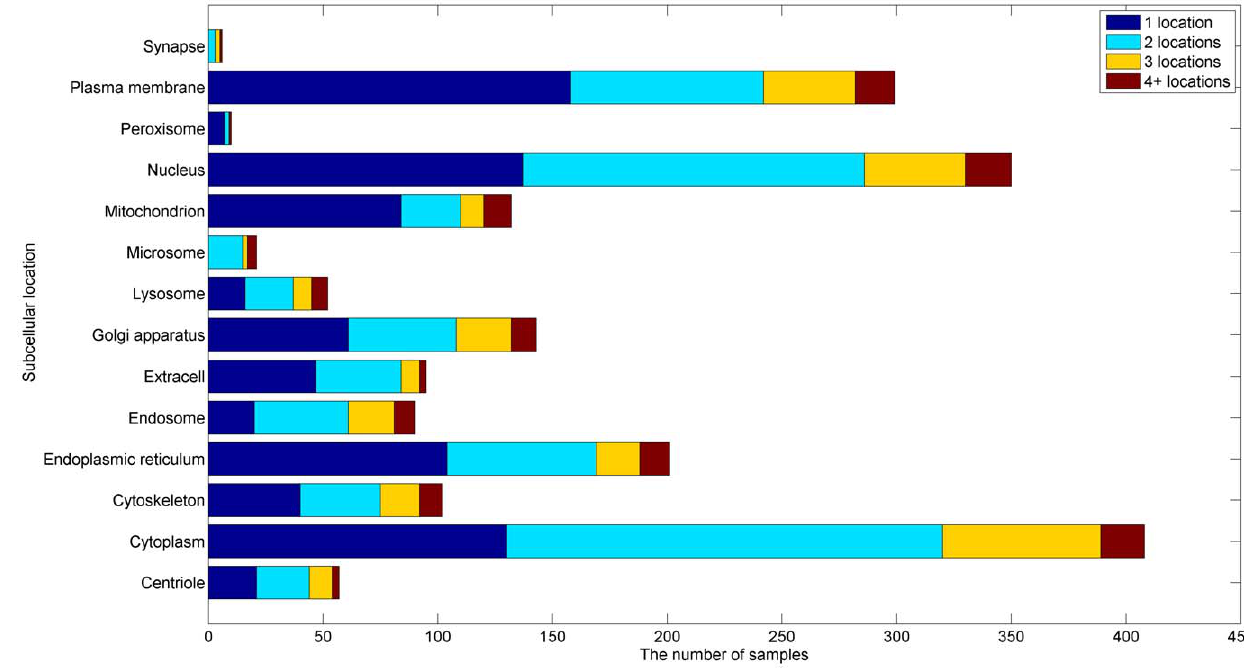
Figure 2. Subcellular distribution of the test samples.